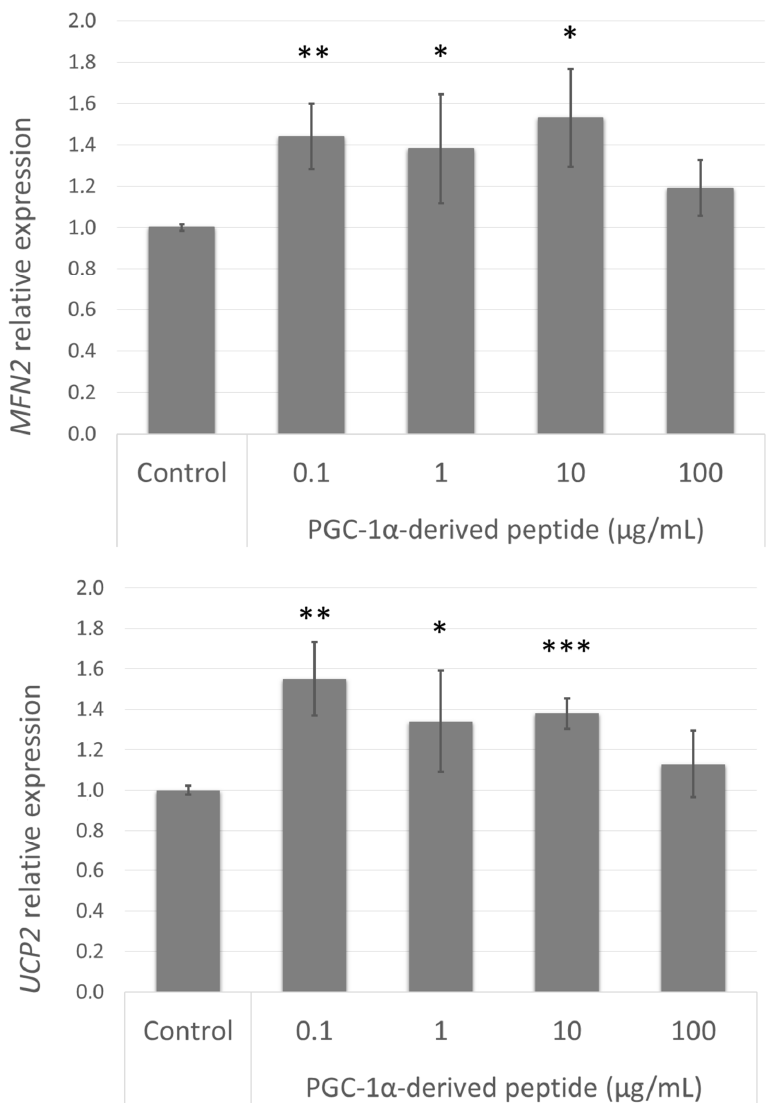
Figure 7. MFN2 and UCP2 gene expression in NHDF cells. NHDF cells were treated with the PGC-1 α -derived peptide at various concentrations for 24 h, then the genes expressions were determined by quantitative RT-PCR. The values represent means ± SEM of at least 3 independent experiments (* p < 0.05, ** p < 0.01, *** p < 0.001 compared with untreated control group).